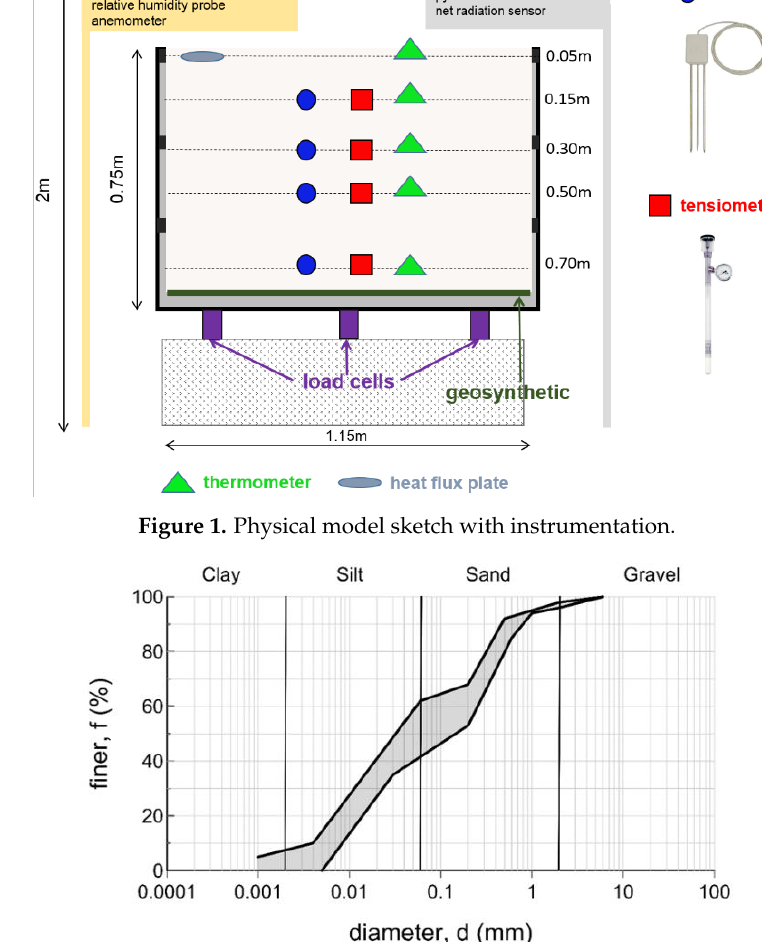
Figure 2. Grain size distribution of the investigated soil.